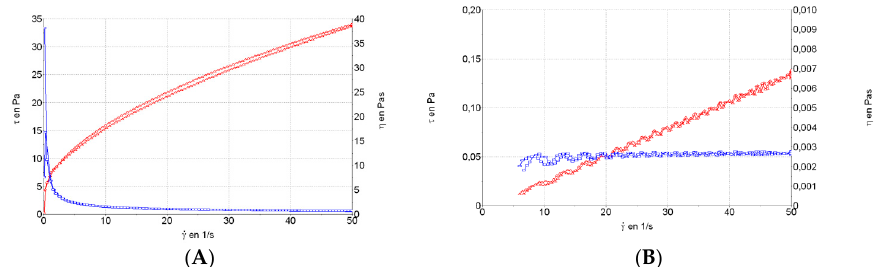
Figure 4. Rheological behavior of ( A ) MA gel and ( B ) MA solution.